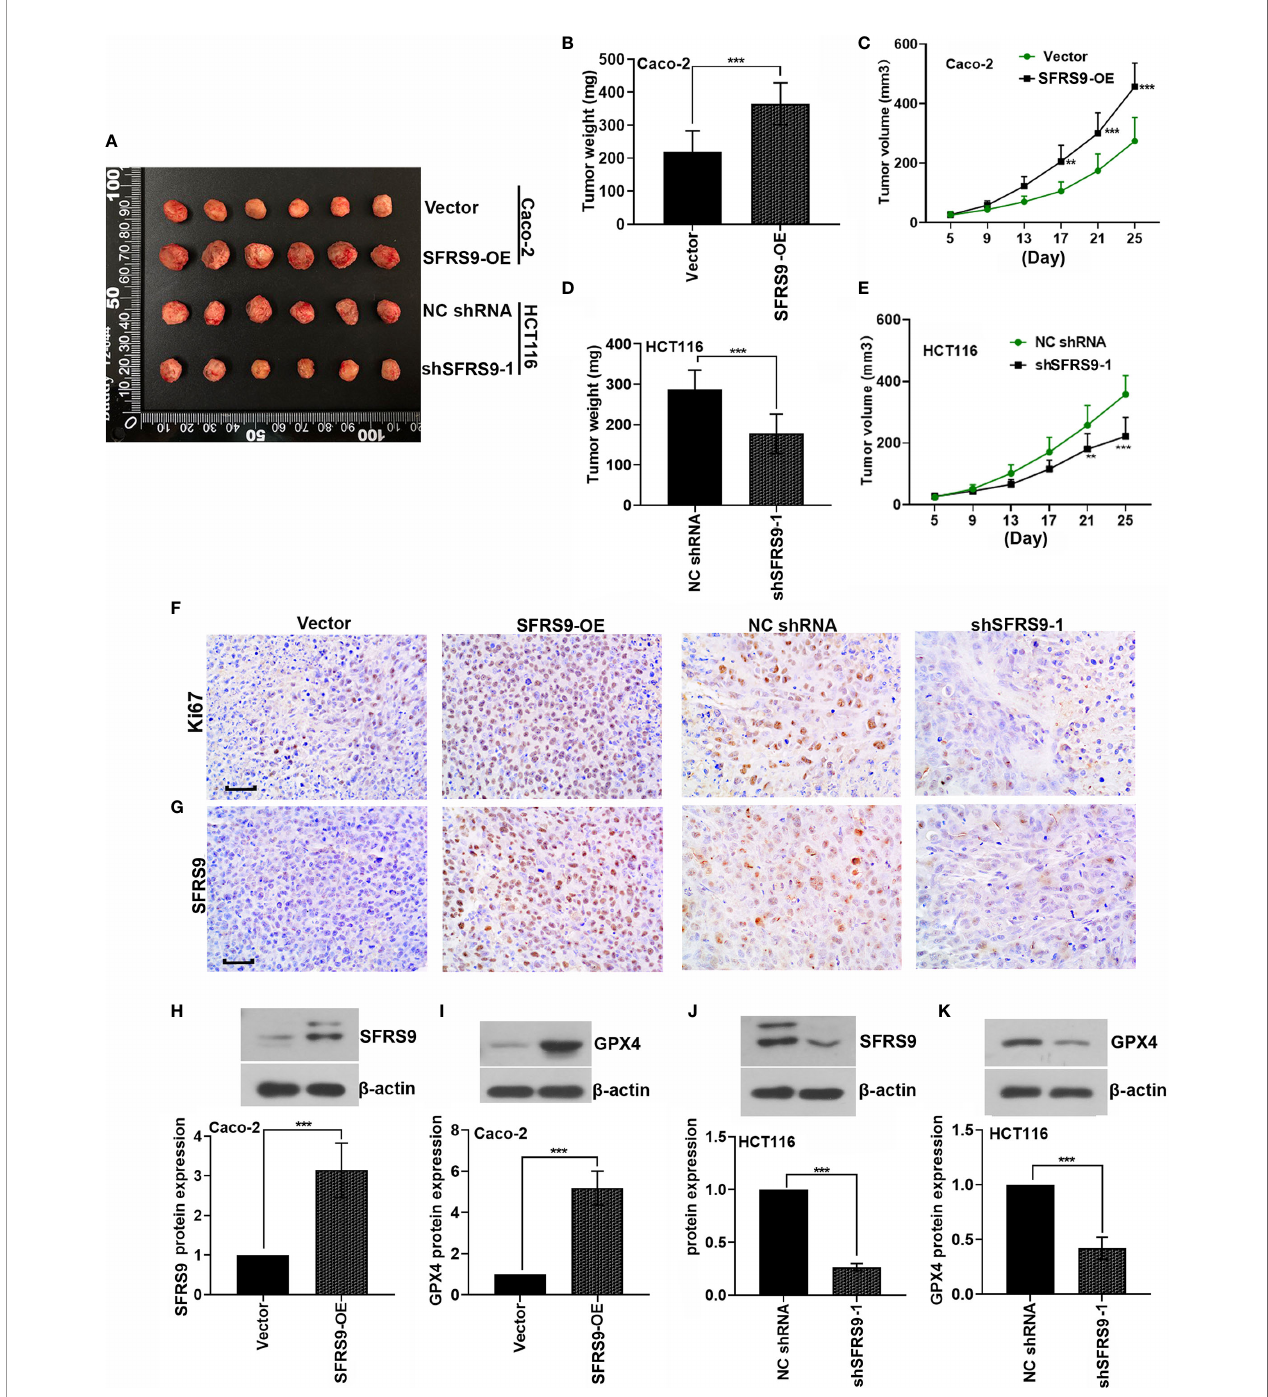
FIGURE 8 | Effect of SFRS9 on the growth of CRC in vivo . (A) Six primary tumors from mice injected with SFRS9-OE vector stably transfected Caco-2 cells or shSFRS9-1 stably transfected HCT116 cells. (B, C) Tumor growth curves and tumor weight of mice injected with Caco-2 cells containing stably transfected SFRS9- OE vector. (D, E) Tumor growth curves and tumor weight of mice injected with shSFRS9-1 stably transfected HCT116 cells. (F) Ki67 expression in the tumor tissues from mice with different treatmentS was detedcted by immumohistochemical staining. Scale bars: 50 m m. (G) SFRS9 expression in the tumor tissues from mice with different treatment was detected by immumohistochemical staining. Scale bars: 50 m m. (H, J) western blot analysis of SFRS9 protein expression in the tumor tissues from mice with different treatments. (I, K) western blot analysis of GPX4 protein expression in the tumor tissues from mice with different treatments. Values are mean ± SD. **p < 0.01, ***p <